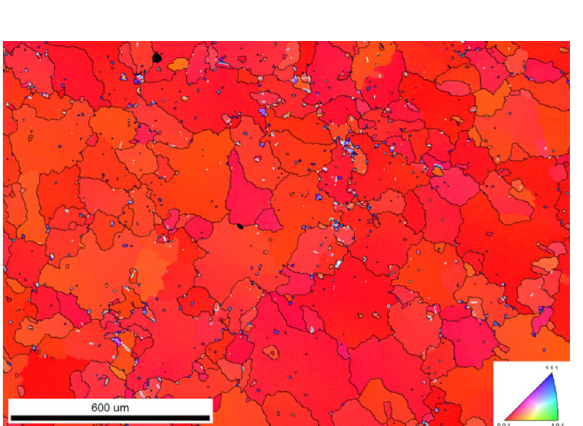
Figure 2. Plan-view EBSD images of the nt-Cu films annealed at various temperatures for 1 h: ( a ) 200 °C; ( b ) 250 °C; ( c ) 300 °C; ( d ) 350 °C.